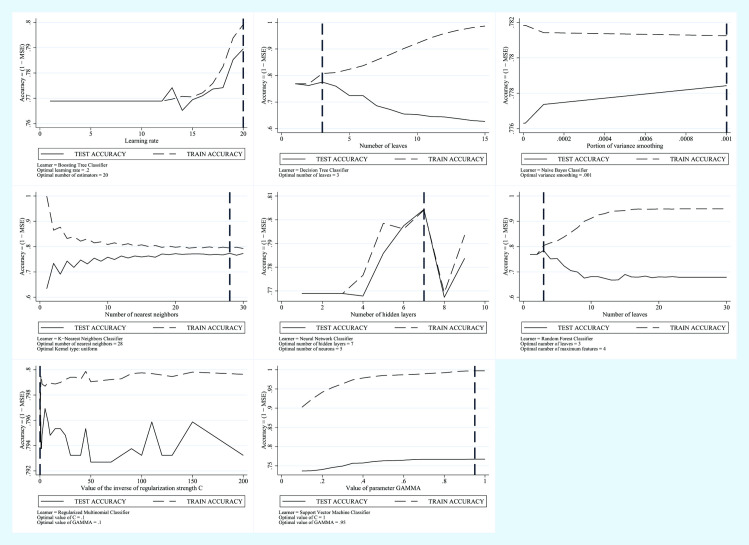
Machine Learning Applied to NAFLD Diagnosis.Training Error vs Test Error for the BRI plus Glucose plus GGT plus Age plus Sex Predictive Model.